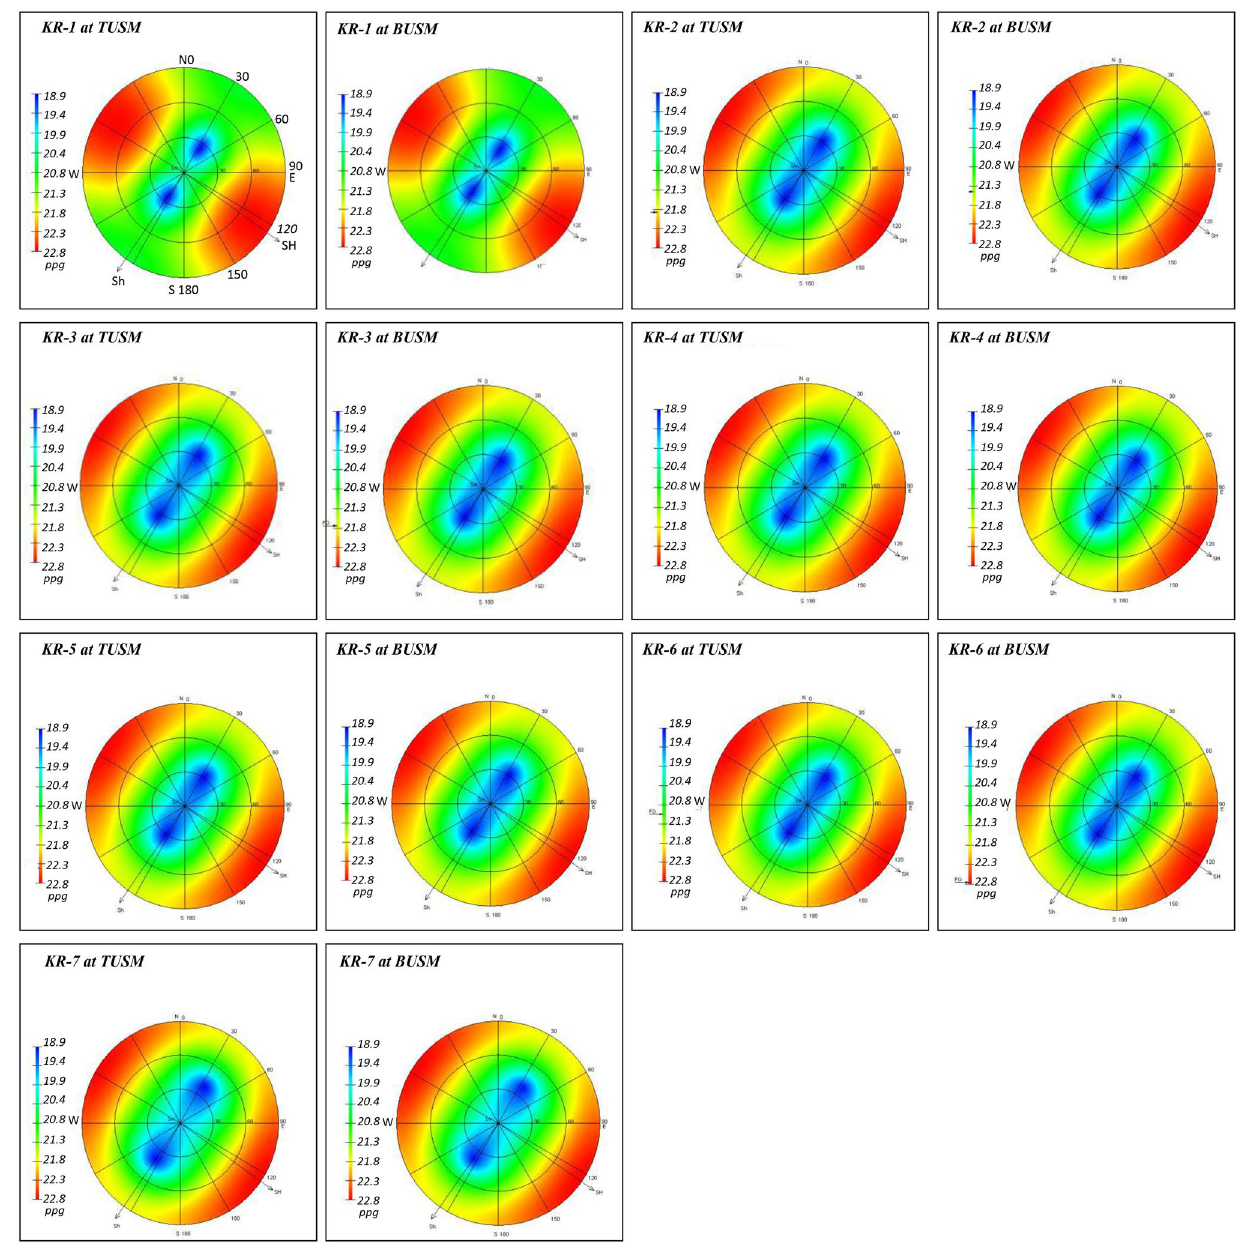
Fig. 9 Lower hemisphere plot for wells at TUSM and